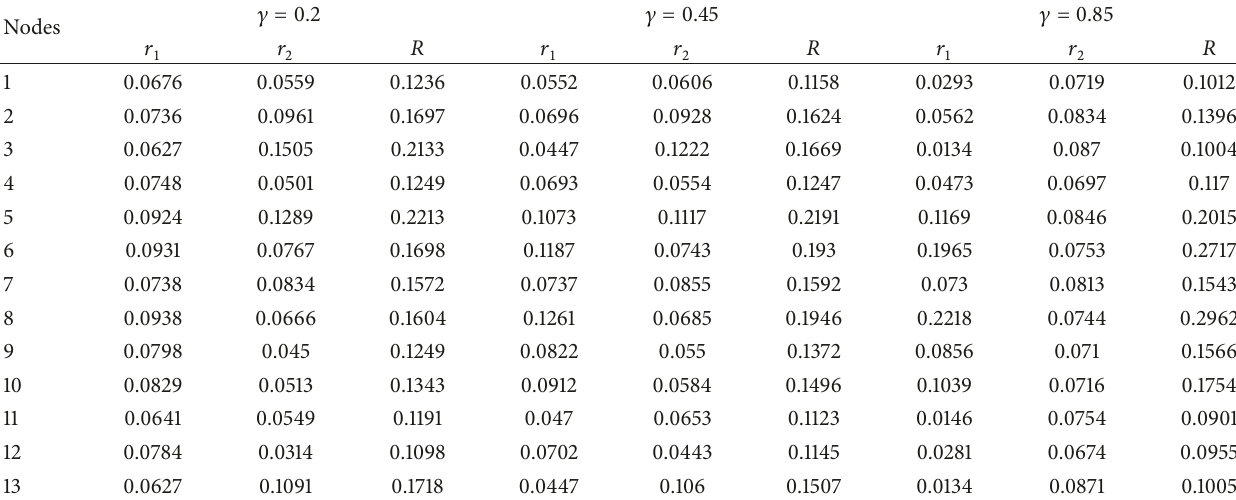
Table 1: The values of the importance of nodes.